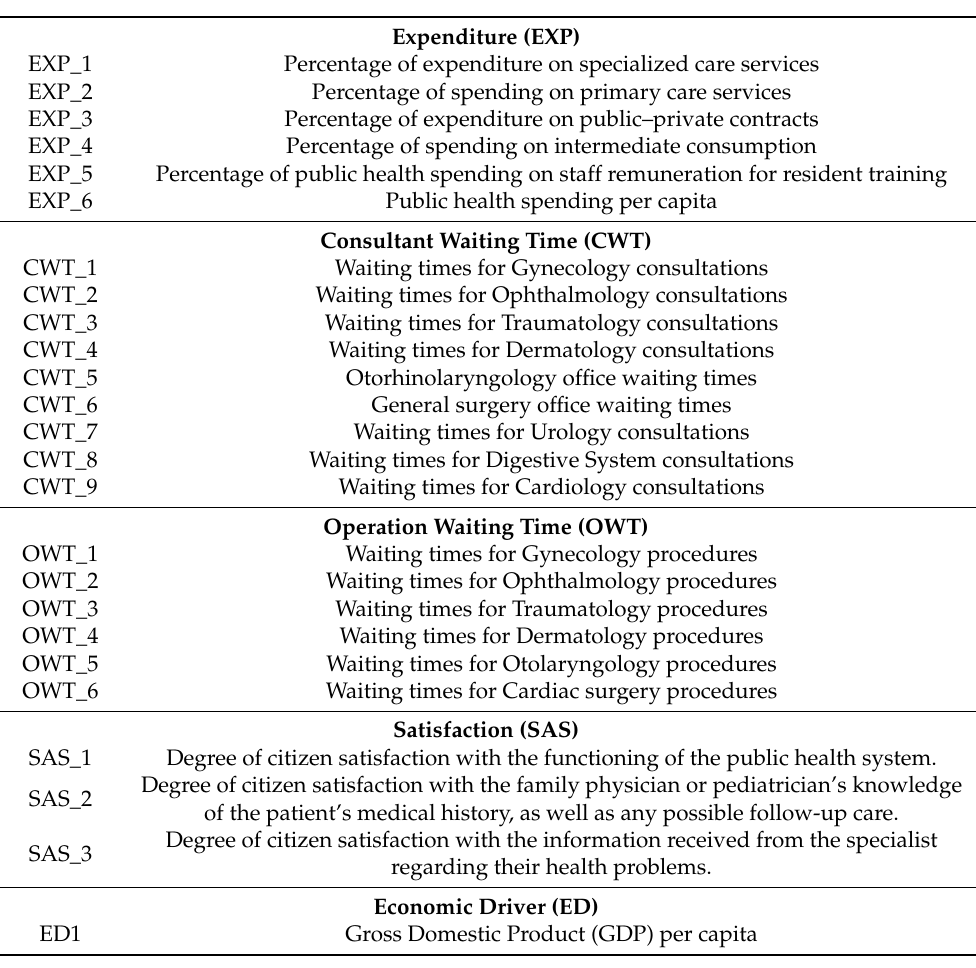
Table 1. Variables used in the